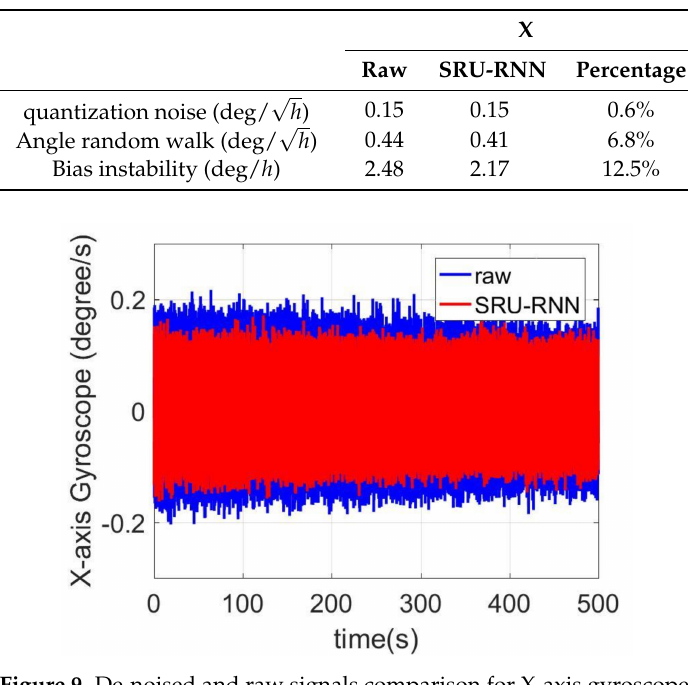
Figure 9. De-noised and raw signals comparison for X-axis gyroscope.